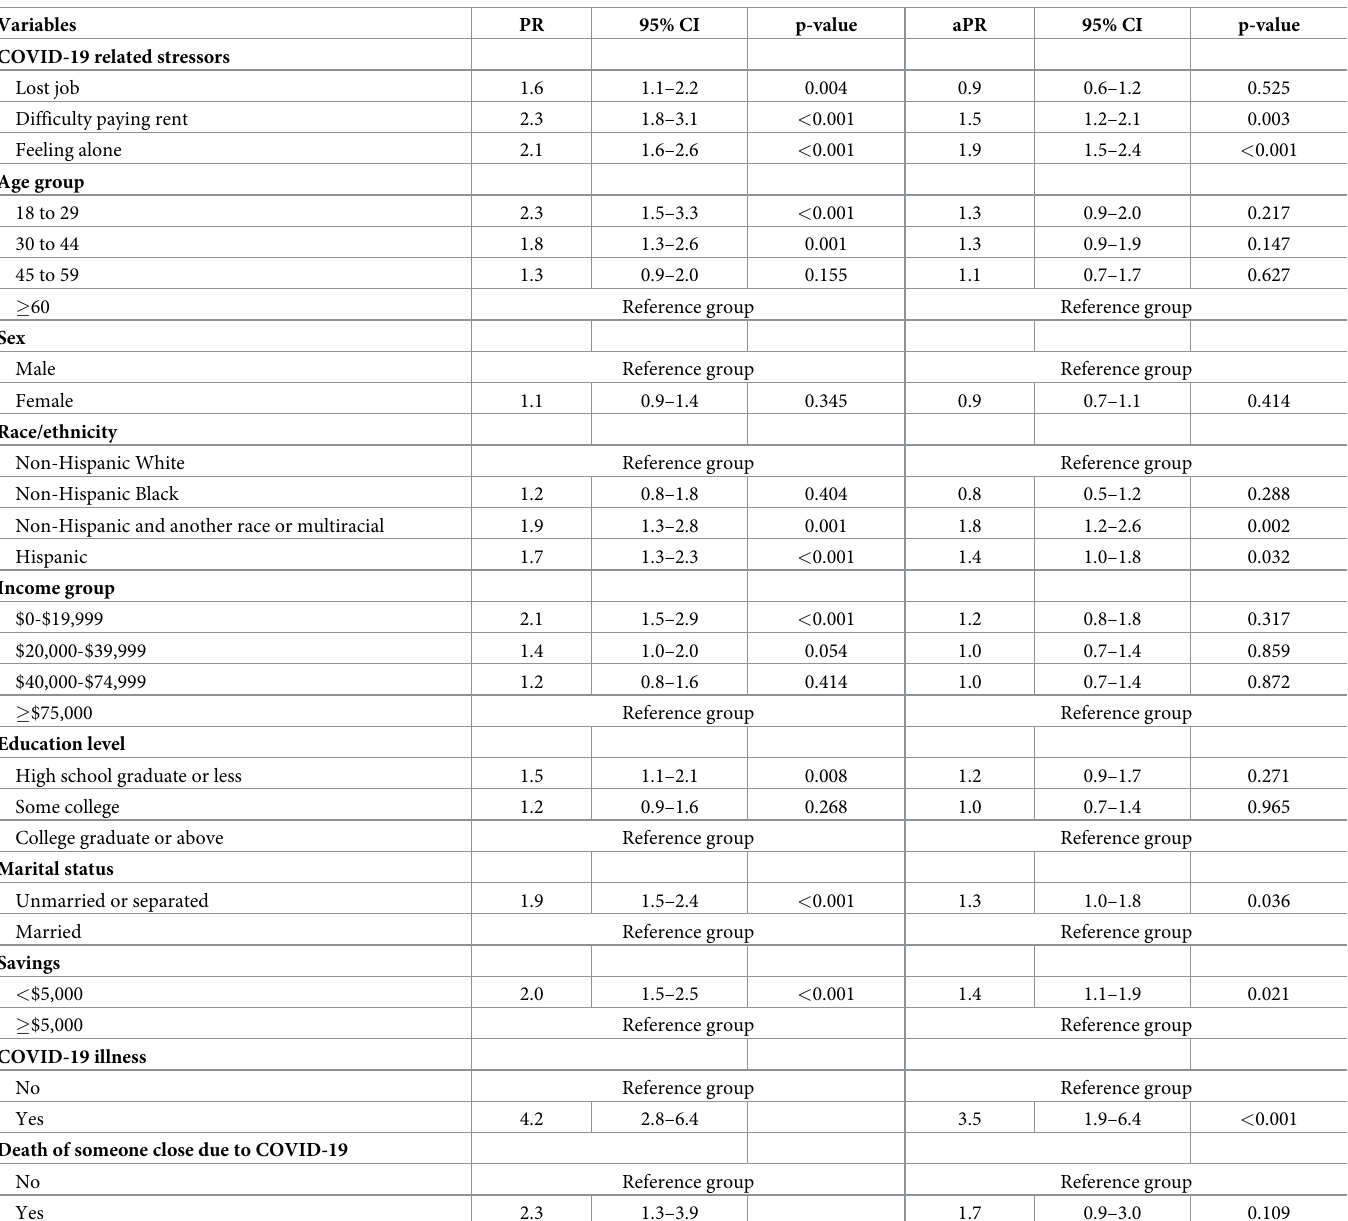
Table 3. COVID-19 related stressors and suicidal ideation over the past two weeks (N = 1415).